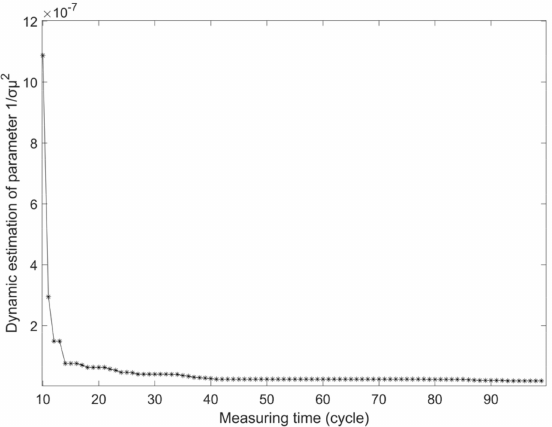
Figure 4. Dynamic estimation of parameter σµ .